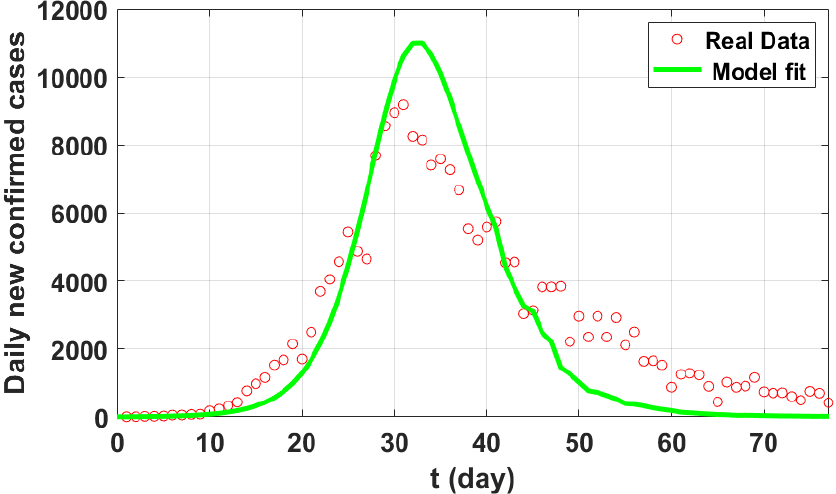
Figure 4. Numerical simulation for system (14 – 16) at 𝐻 ∗ = 0.8, 𝛼 = 0.9, 𝛼 1 = 1 , 𝜎 1 = 𝜎 2 = 𝜎 3 = 0.01 , 𝜎 4 = 𝜎 5 = 𝜎 6 = 𝜎 7 = 𝜎 8 = 0.1 .